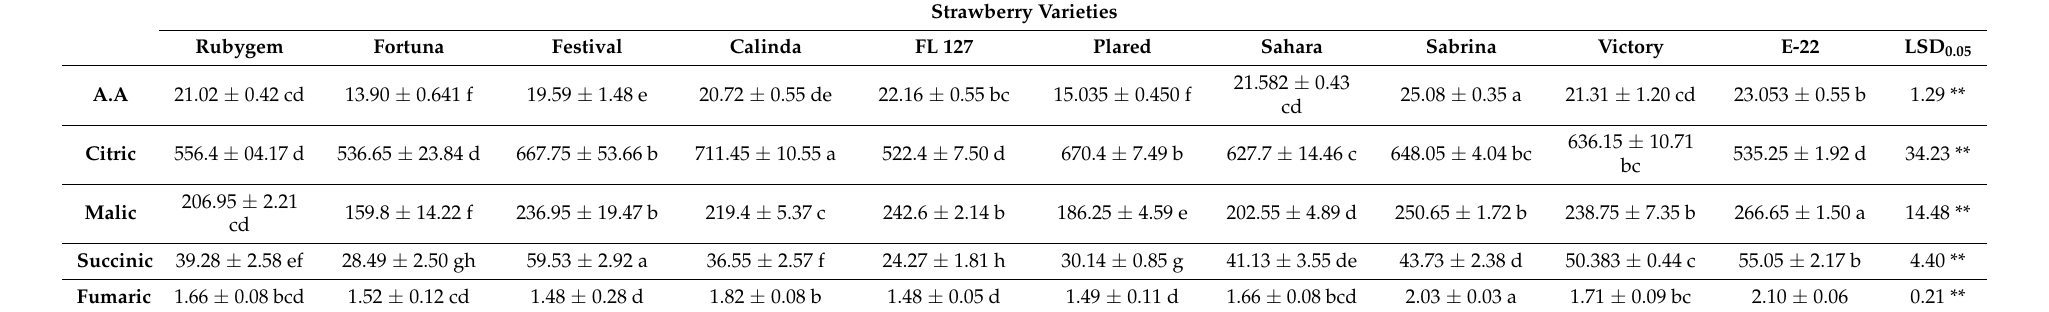
Table 3. The content of organic acids in fruits of ten strawberry varieties (mg per 100 g − 1 FW).